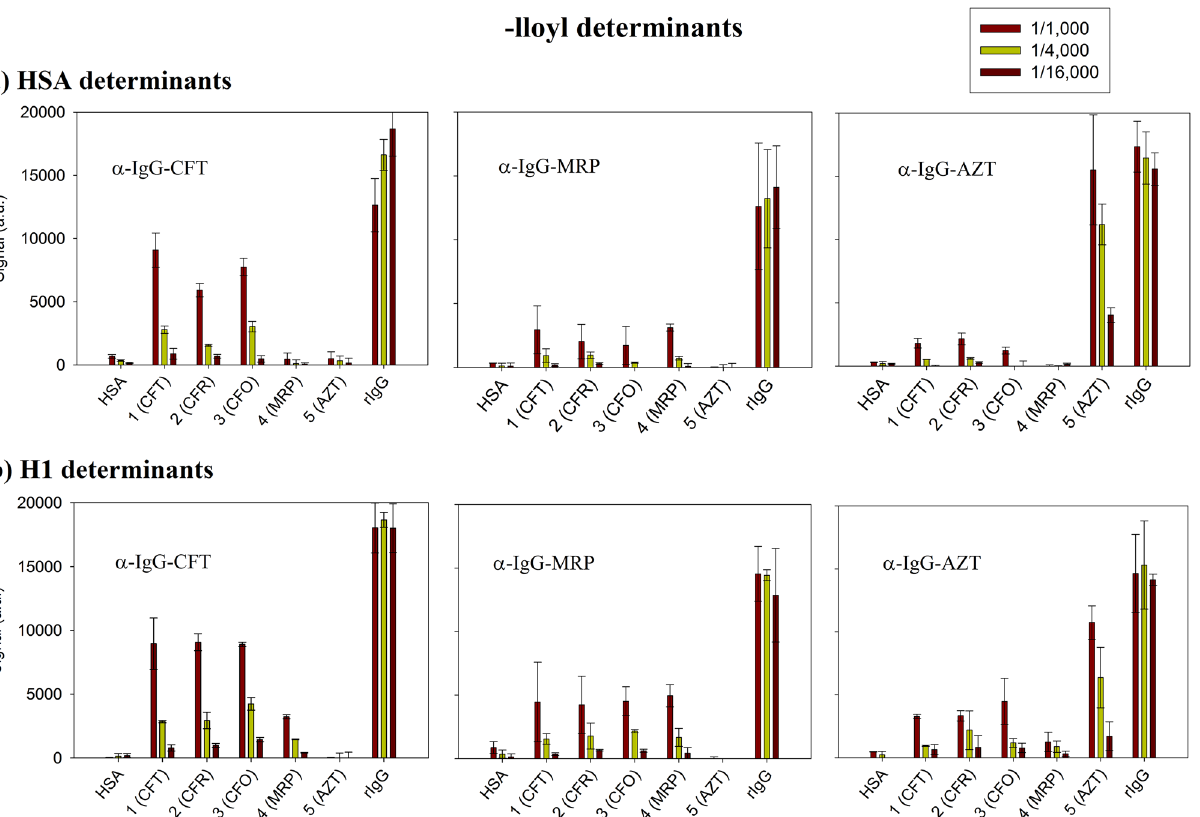
Figure 6. Signals obtained for the -lloyl determinants with polyclonal rabbit IgG. Dilution factors: 1/1000, 1/4000 and 1/16,000). ( a ) HSA determinants; ( b ) H1